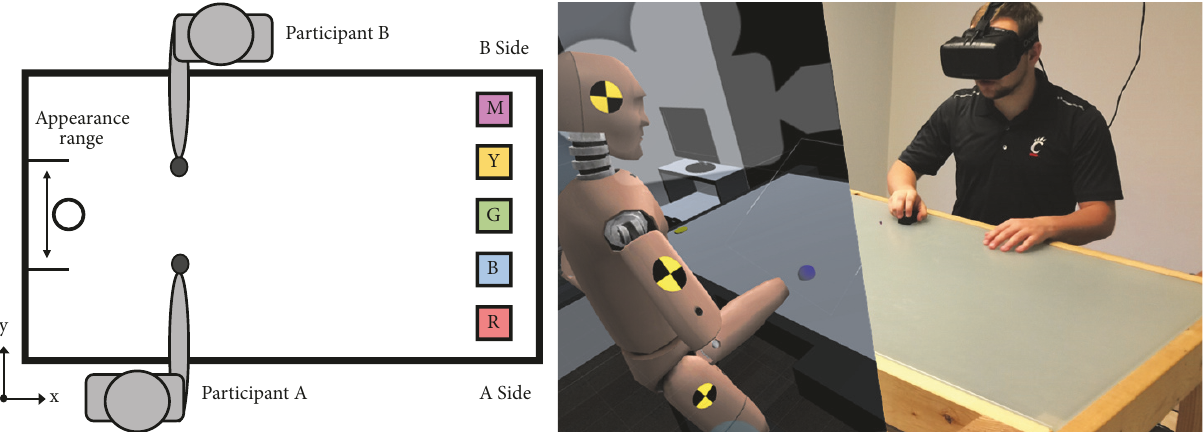
Figure 3: Experimental setup and testing environment. ( left ) Birds-eye view illustration of the task space layout. The large black rectangle represents the tabletop, with the object appearance region on the left and the five colored object drop-off locations on the right: M=magenta, Y=yellow, G=green, B=blue, R=red. The circle on the left in the middle of the appearance location region represents a disk object. ( right ) Participants performed the task in a virtual environment, with a 1:1 mapping between the real and virtual tabletops.